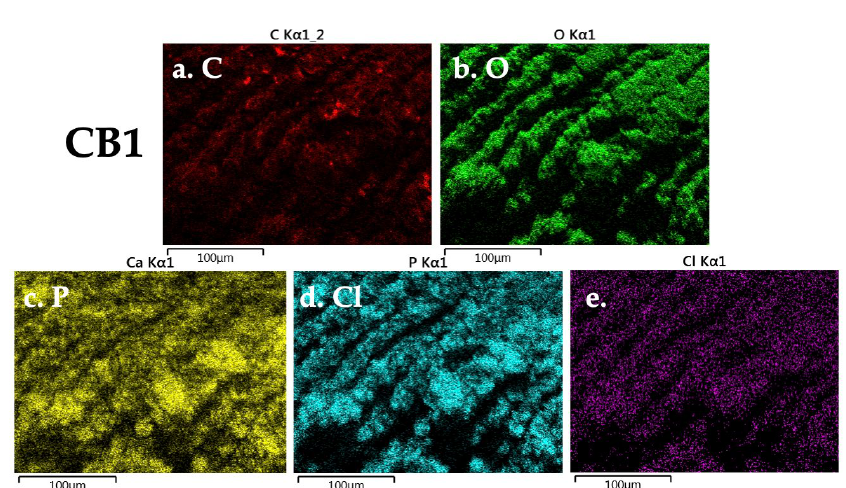
Figure A1. EDX identified elements for CB1: ( a ) C, ( b ) O, ( c ) Ca, ( d ) P, ( e ) Cl .